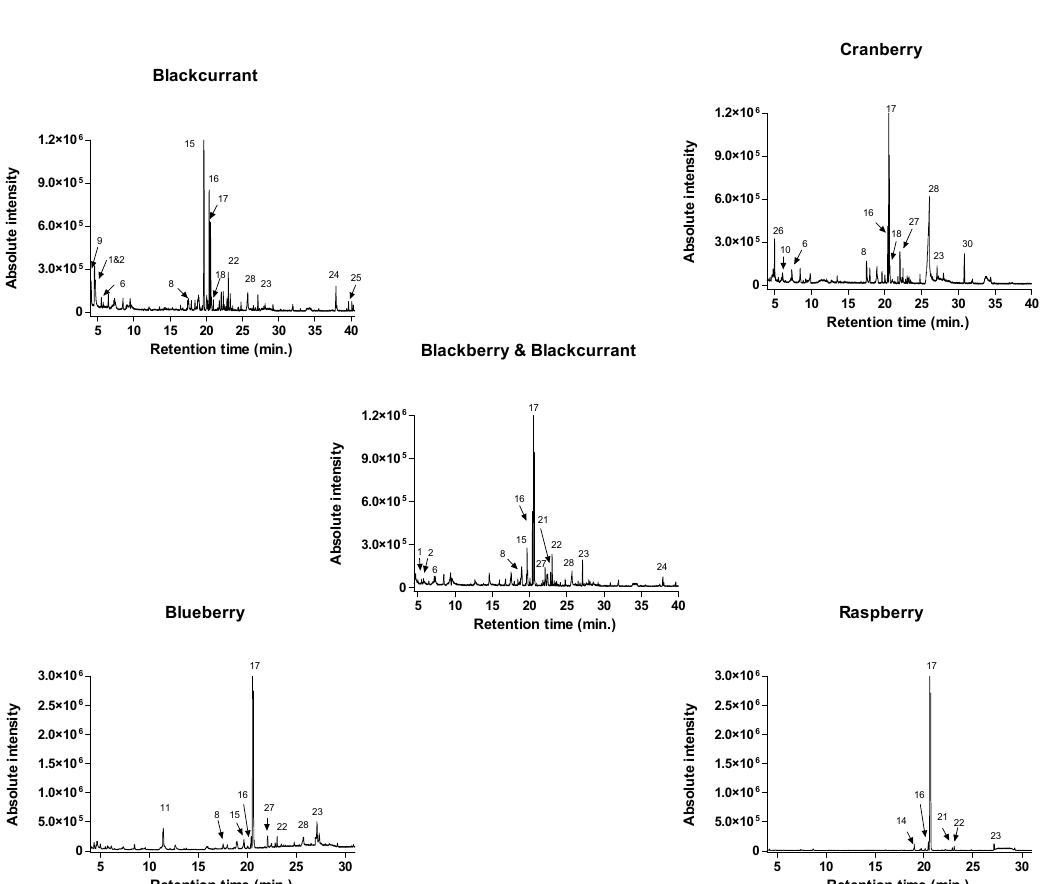
Figure 2. Chromatograms (TIC, total ion chromatogram) of headspace ITEX / GC–MS analysis of volatiles from the selected jams. The numbering of the peaks refers to Table 3.